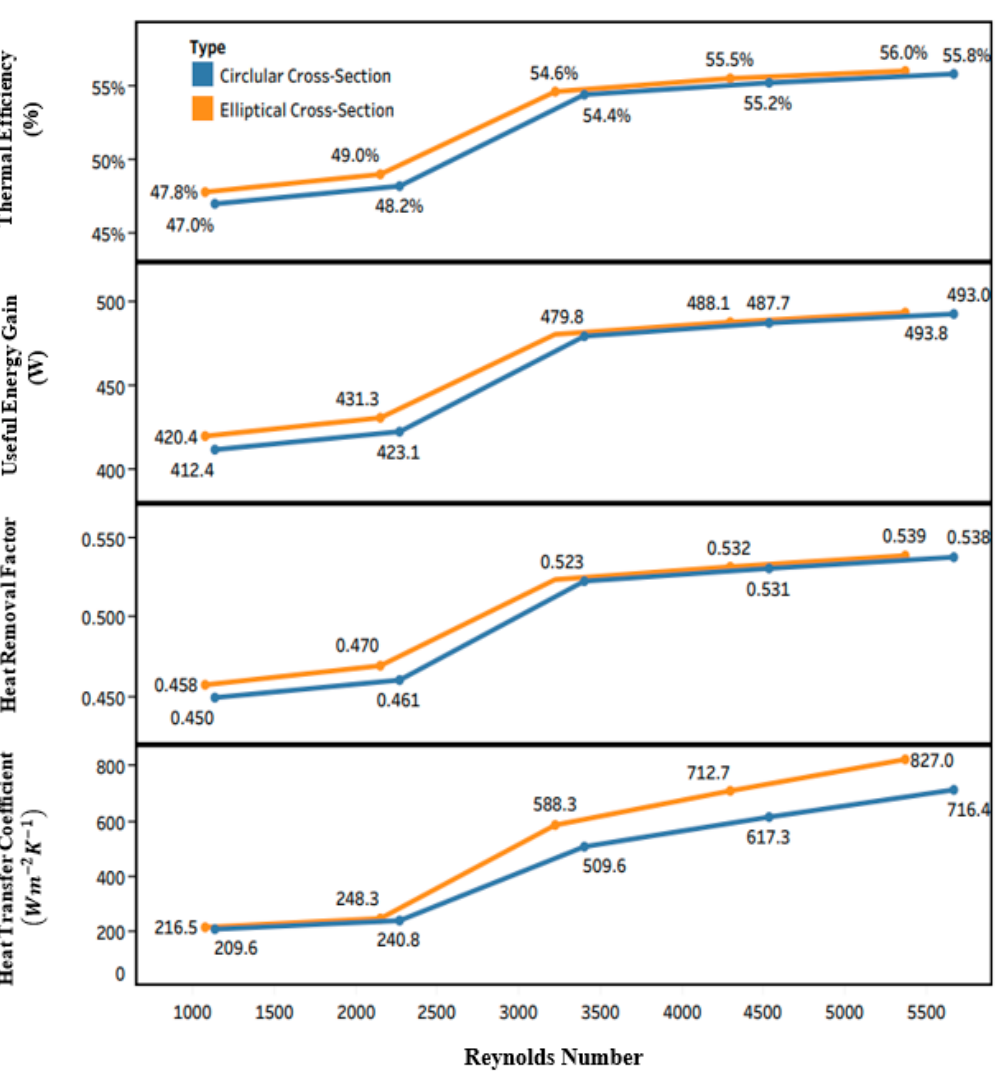
fi , F R , Q u , and µ Th